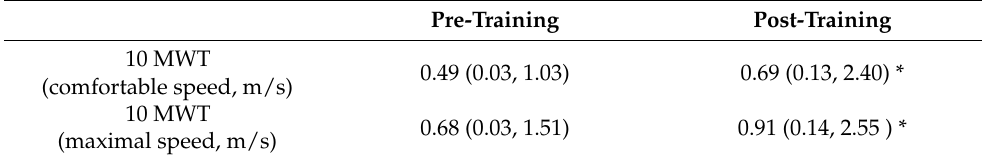
Table 4. Ten-meter walk test distances at pre-and post-training time points.